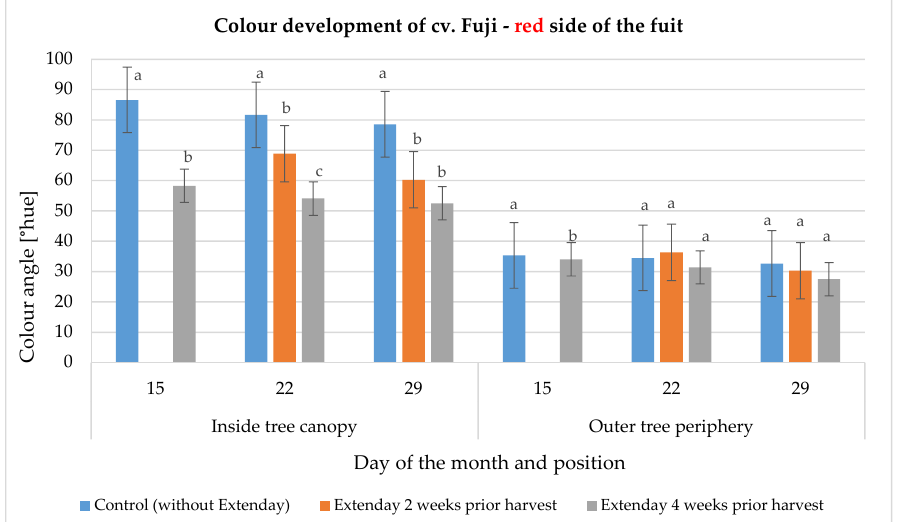
Figure 7. Colour development dependent on fruit position within the tree of cv. Fuji as measured on 15, 22 and 29 March on the inner green side of the fruit as affected by reflective mulch. (Treatments with different letter for the same position of the fruit within the same day are statistically different ( p < 0.05) (n = 60 fruit per treatment per position)).